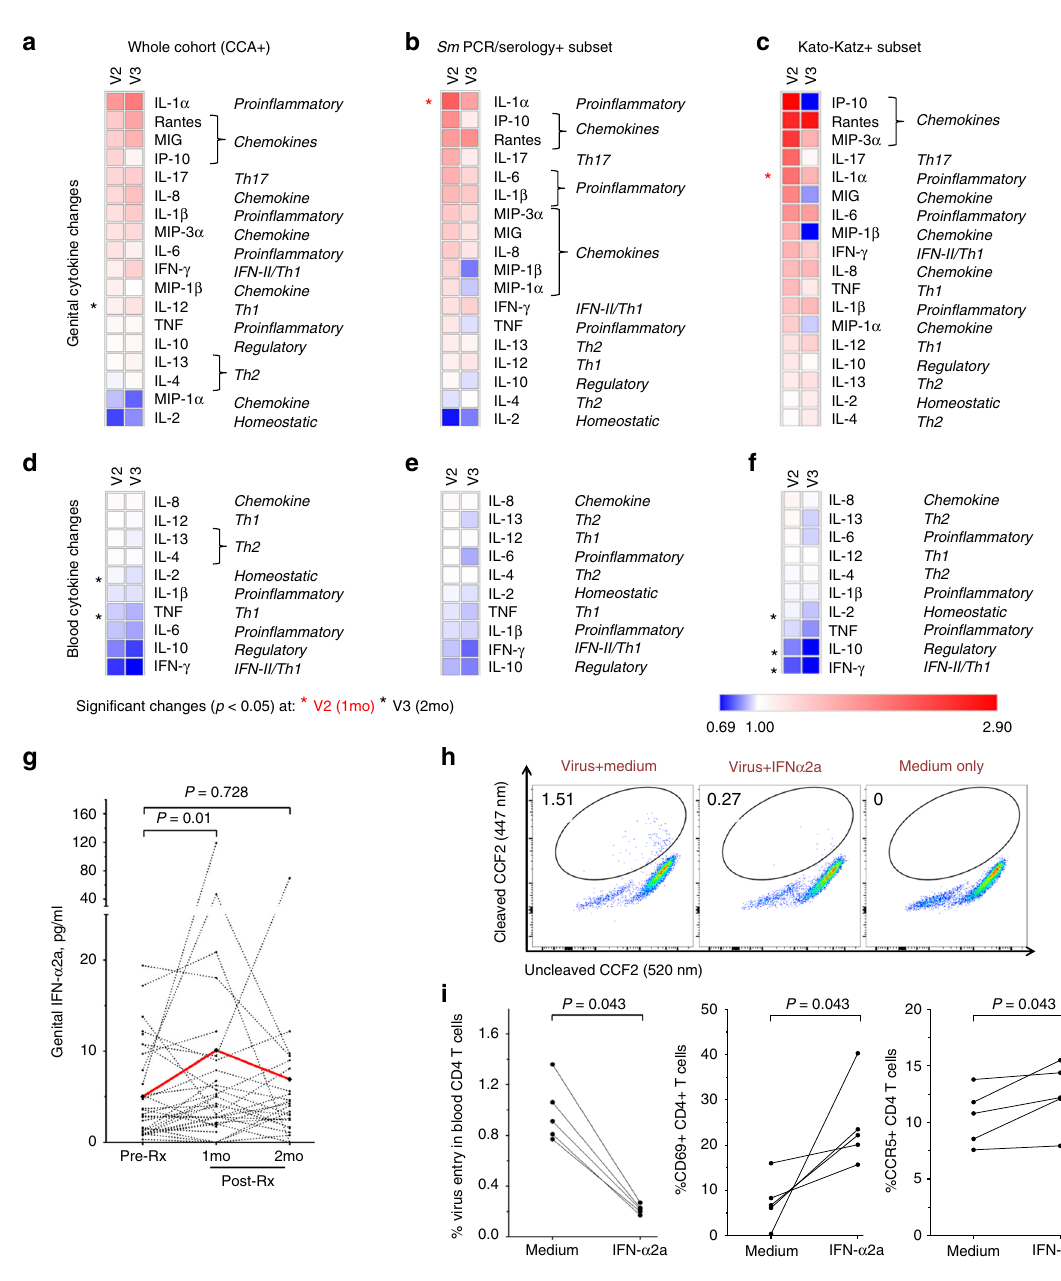
Fig. 3 Genital and systemic cytokines before and after Sm treatment and IFN- α effects on cellular HIV entry. a – f Genital ( a – c ) and blood ( d – f ) cytokine level changes represented as the geometric mean of fold change of each cytokine at post-treatment visit (V2 or V3) over pre-treatment level in: ( a , d ) CCA + , ( b , e ) S. mansoni PCR/serology + and ( c , f ) Kato-Katz + participants. Cytokines were plotted in descending V2/V1 fold change order. Each cytokine was assigned a category (right of heatmap) based on their function or sub-type. Scale denotes fold changes ranging from 0.69 to 2.90 and where 1.0 is “ no change ” . The numbers of participants with paired samples analyzed are in a : V2 = 31, V3 = 24; in b : V2 = 22, V3 = 17; in c : V2 = 12, V3 = 10; in d : V2 = 30, V3 = 25; in e: V2 = 22, V3 = 16; in f : V2 = 12, V3 = 10. See the Source Data fi le for raw cytokine concentrations for all participants at each study visit. g Plots depicting individual participant changes in genital IFN- α 2a across the study visits in S. mansoni PCR/serology + participants ( n = 22). Red lines depict mean cytokine concentration at each visit. h – i Flow cytometric analysis of HIV entry and CD69 and CCR5 expression in blood CD4 + T cells ex vivo stimulated by IFN- α 2a (100 ng/ml). Representative plots for HIV entry, CD69 and CCR5 expression are shown in ( h ) and Supplementary Fig. 9c, d. Experiments were performed with three technical replicates per participant and each data point in ( i ) represents an average of three values per individual. Signi fi cance was assessed by paired t -test ( a – g ) or Wilcoxon signed rank test ( i ). Source data are provided as a Source Data fi le. Sm: Schistosoma mansoni CCR5-tropic HIV entry 33 . Using the interferome database we signaling was identi fi ed among the top 10 enriched pathways (Fig. 4b) and there was post-treatment up-regulation of genes then assessed whether the DEGs associated with Sm treatment involved in antiviral immunity (Fig. 4a, b, Supplementary were enriched for IFN and IFN-I regulated genes (IRG and IRG-I, Fig. 10), including signal transducer and activator of transcription respectively). One-month post-treatment DEGs were enriched for ( STAT )- 1 , IL-22 , IL-24 and interferon-induced transmembrane both IRG (28%, p < 0.001) and IRG-I (17%, p = 0.013), while the protein ( IFITM ) − 1 , a cell membrane-associated inhibitor of two-month visit was not enriched for either IRG (24%, p = 0.579) NATURE COMMUNICATIONS| (2019) 10:2296